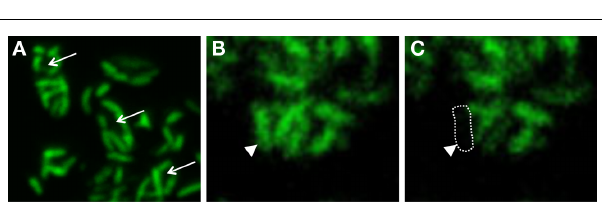
FIGURE 4 | “ Chlorochromatium aggregatum ” consortia after calcein AM staining. (A) Arrows pointing toward unstained central bacteria. (B,C) Consortium before and after photo-bleaching; arrows pointing toward bleached epibiont cell.